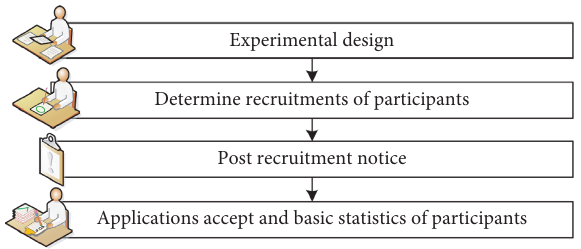
Figure 3: Participant selection flow.